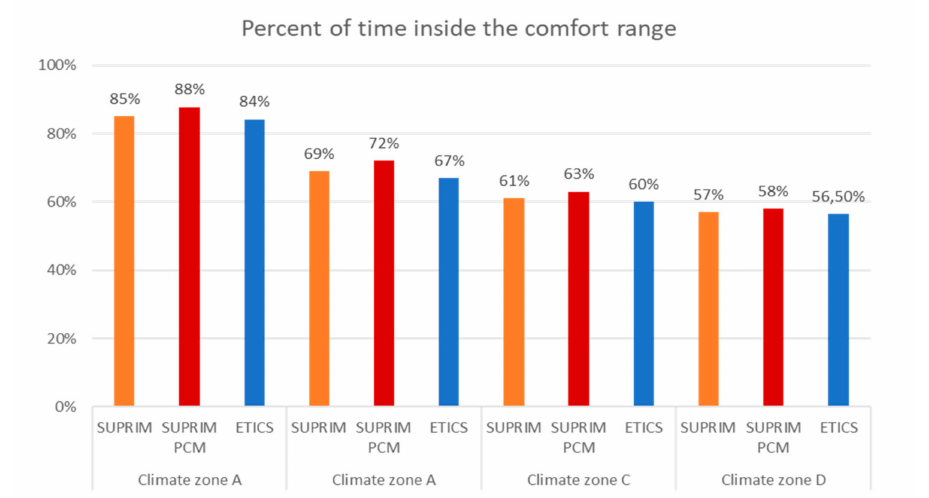
Figure 7. Annual percentage of the total occupancy time inside the comfort conditions for the three examined wall types, assuming 10 cm external thermal